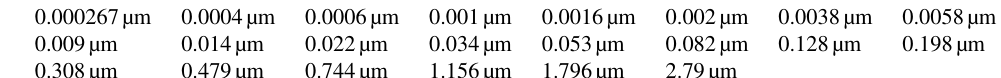
Table 3. Table shows the distribution of the 22 aerosol size bins for the radii of the particles employed in the CARMA model.